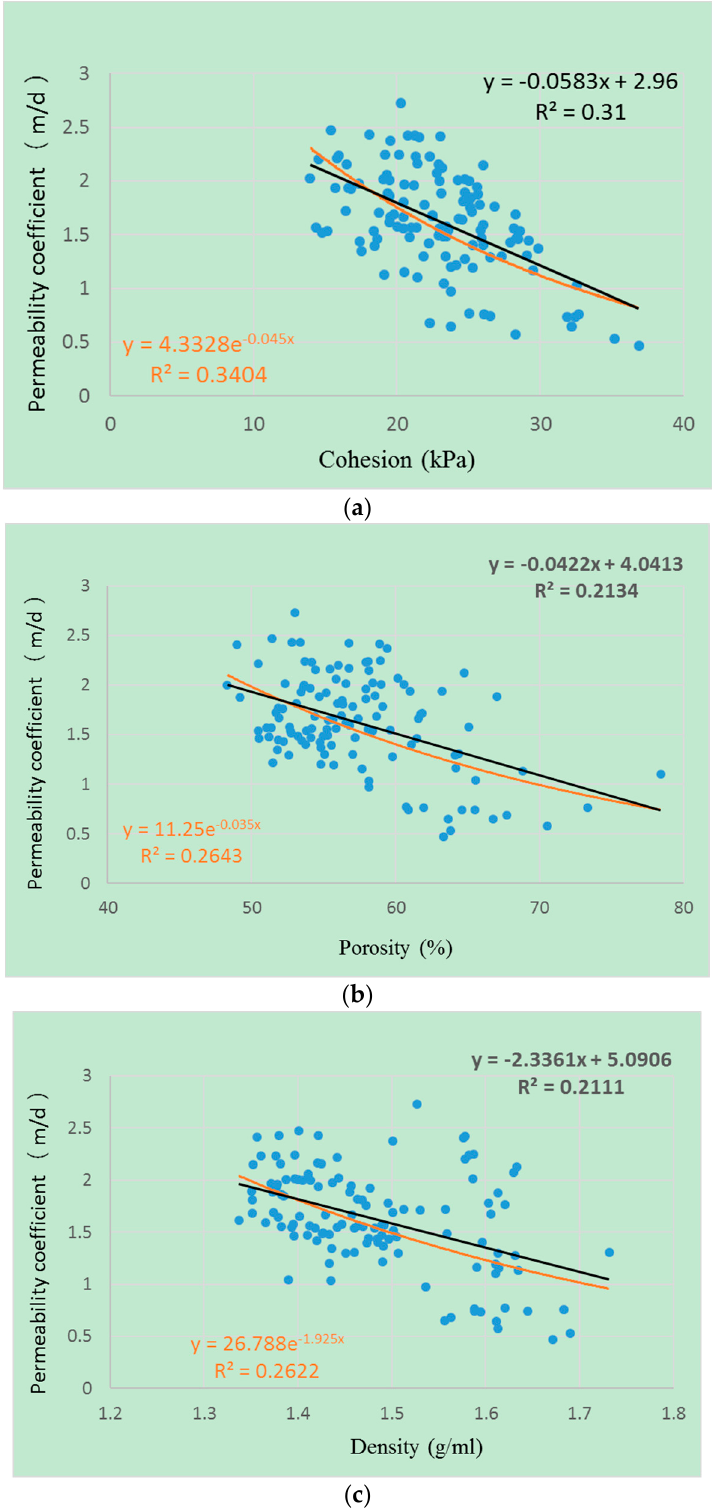
Figure 13. Fitting relationships between the permeability coefficient and cohesion ( a ), porosity ( b ), and density ( c ) in which the black lines and equations are of linear relationships, while brown lines and equations are of exponential relationships.